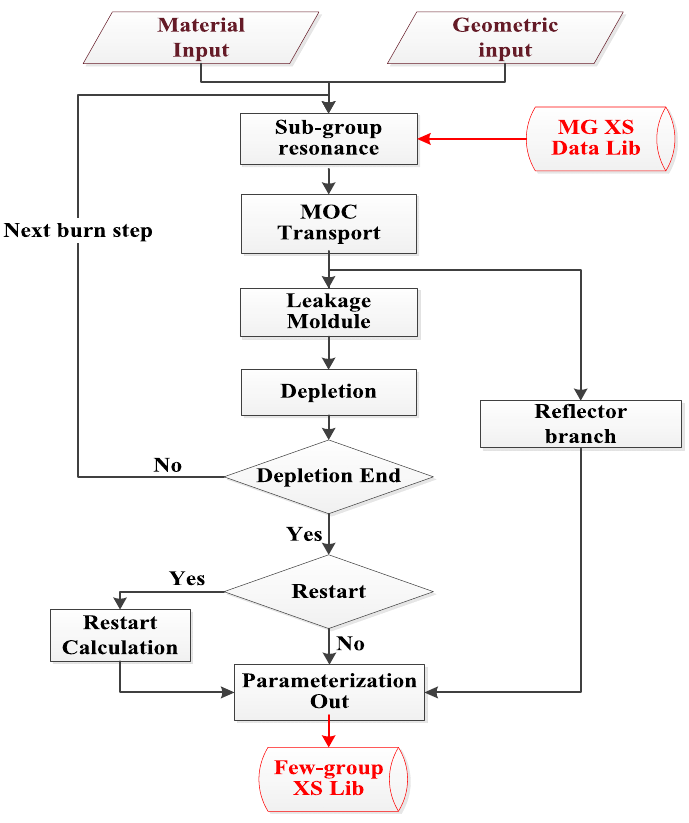
Figure 1. Main flowchart of